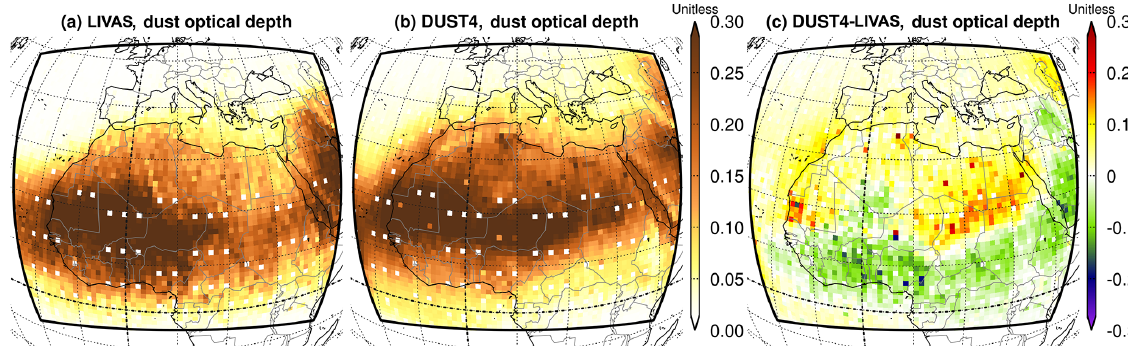
Figure 3. Dust optical depth of the DUST4 experiment and the LIVAS dust product for the period January 2007 to November